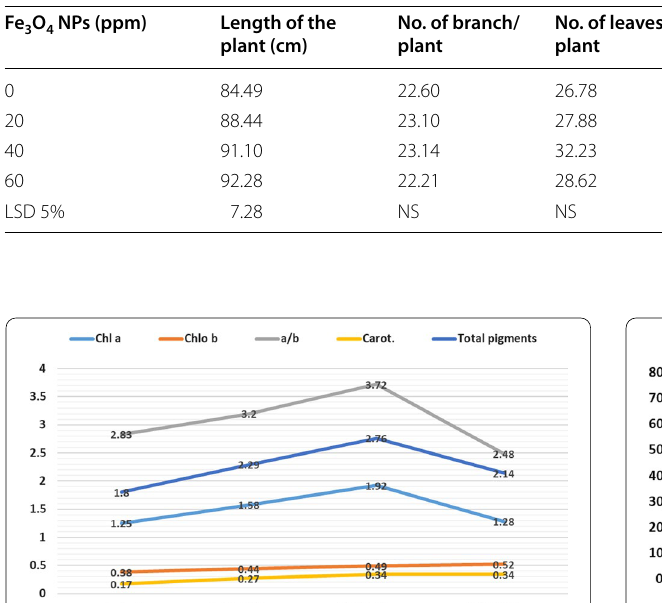
O nanoparticles treatments on some growth parameter of Moringa oleifera L. 3 4